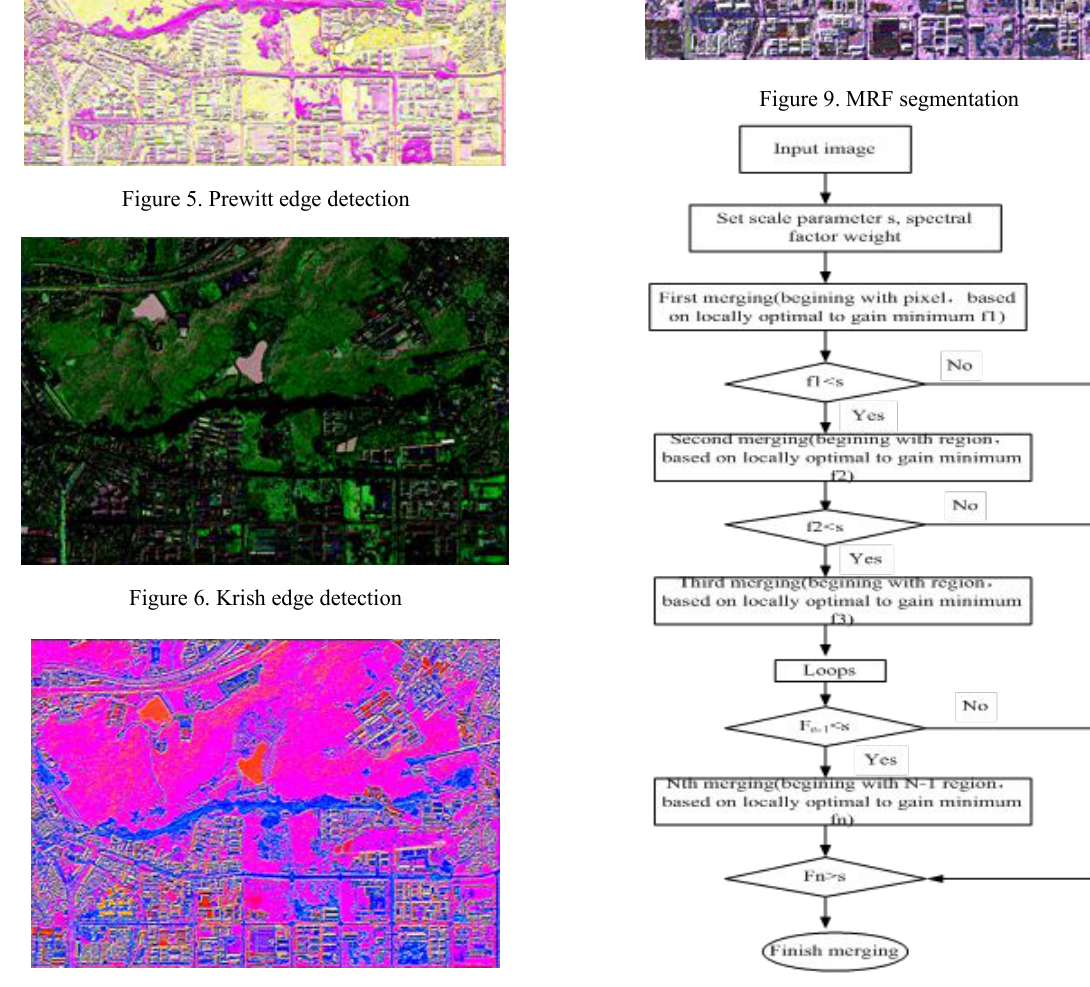
Figure 7. Guass-Laplacian edge detection